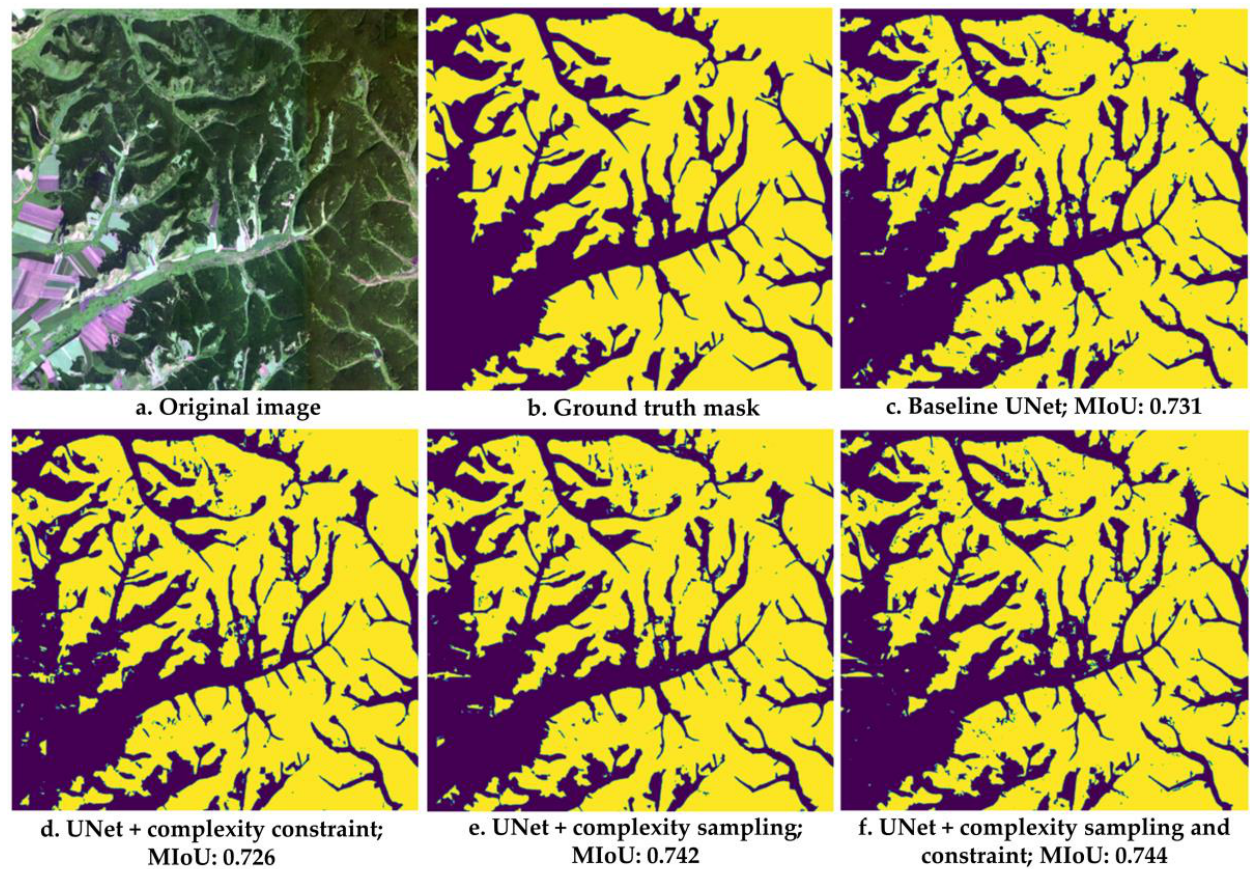
Figure 11. Comparison between forest segmentation results of baseline UNet, UNets with complexity-informed constraint/sampling, and UNet with both. ( a ) shows the RGB images depicting true colors; ( b – f ) display yellow masks representing the forest feature for ground truth ( b ) or predictions ( c – f ).